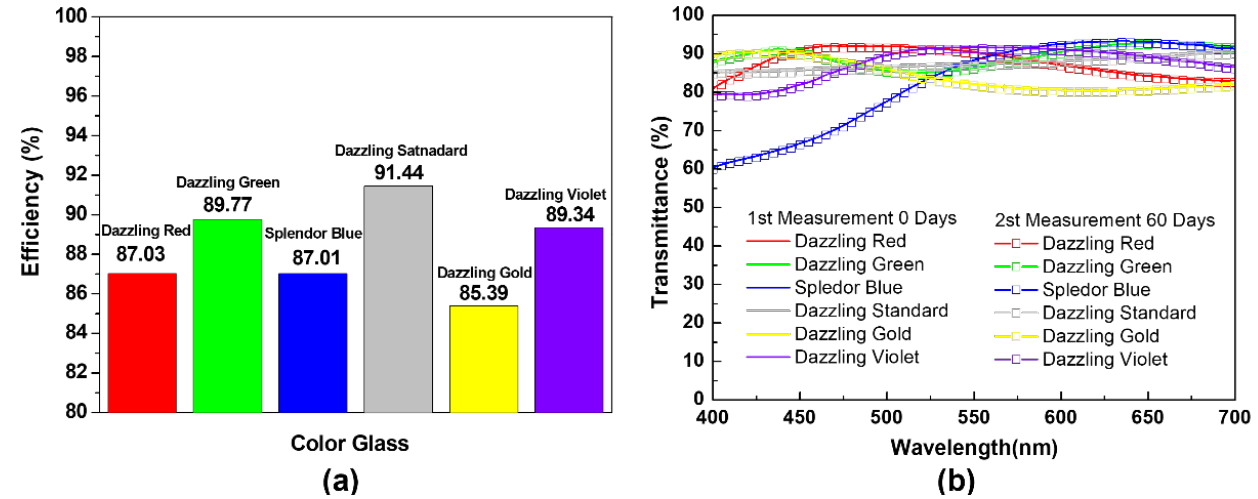
Figure 7. ( a ) Power generation efficiency evaluation of solar cells laminated with color glass. ( b ) Transmittance spectrum of color films measured after 60 days. mittance spectrum of color films measured after 60